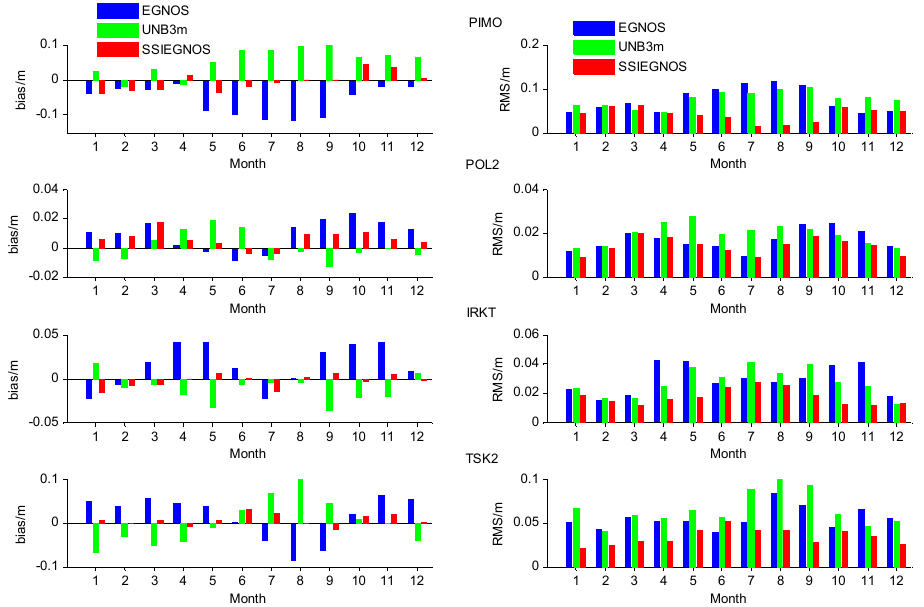
Figure 16. Monthly mean predicted bias and RMS from 2011–2012 at the TSK2, POL2, IRKT, and TSK2 sites. The blue bars, green bars, and red bars denote the monthly bias and RMS error of the EGNOS, UNB3m, and SSIEGNOS models, respectively.